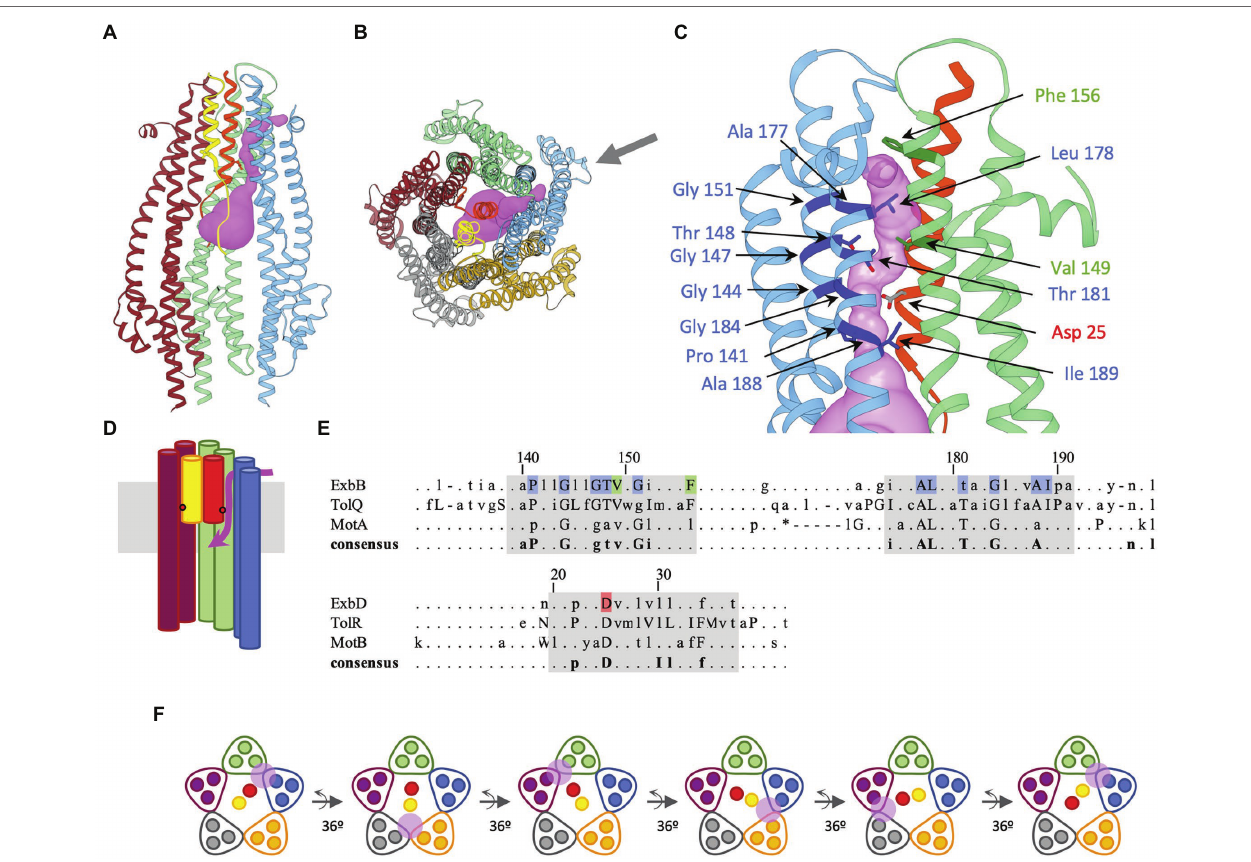
FIGURE 2 | Predicted proton channel in Ec ExbBD, sequence conservation of residues lining the channel, and rotary model of the ExbD TMs in the ExbB pentamer. The color coding of the different subunits is the same as in Figure 1 . (A) Ribbon representation of the Ec ExbBD complex (pdb 6TYI), with the predicted proton channel represented as pink isosurface. For clarity, two ExbB subunits (grey and orange) have been omitted to reveal the interior of the complex. The blue and green Ec ExbB subunits are involved in the channel formation. The TM helices of Ec ExbD are colored yellow and red, with the side chains of the essential Asp25 represented as ball and sticks. The red helix is involved in the formation of the channel. (B) Same ribbon representation as (A) , but viewed from the periplasm, all the Ec ExbBD subunits are shown. The online version of Mole 2.5 (https://mole.upol.cz/; Pravda et al., 2018) was used to probe for cavities and channels in the Ec ExbBD structure. The same parameters reported for the Cj MotAB channel (Santiveri et al., 2020) were used: 1 Å radius bottleneck, and omission of Leu178 side chain for the calculation. The black arrow shows the direction of viewing for (C) . (C) Enlarged view of the channel. Only the Ec ExbB and Ec ExbD subunits involved in the channel formation are shown (blue, green, and red). The most conserved residues in the consensus sequence shown in (E) are highlighted in darker colors and side chains are shown as ball and stick. (D) Schematic representation of (A) , showing the path of the channel. Only the TMs 2 and 3 of the blue, green, and purple Ec ExbB subunits are shown. The approximate location of the conserved Asp on Ec ExbD TM is shown with red dots. The membrane is shown in grey. The channel is symbolized in pink. It opens between the blue and green Ec ExbB subunits on the periplasmic side, connects to the Asp25 of the red Ec ExbD TM, and opens on the cytoplasmic cavity of the Ec ExbB pentamer. (E) Consensus from the multiple sequence alignment of ExbB/TolQ/MotA last two TM domains and ExbD/TolR/ MotB TM domain, adapted from Figure 4 from Cascales et al. (2001). Lowercase letters represent residues present in the 60% consensus and uppercase letters for residues in the 90% consensus. Gaps are marked “–” and “*” when present in the 90 and 60% consensus, respectively (Cascales et al., 2001). The numbering corresponds to the E. coli sequences of ExbB and ExbD. The highlighted residues in blue, green, and red are the ones shown with arrows on (C) . They all are in the 90% consensus range, except for Thr181. The regions highlighted in grey correspond to the last two TMs of ExbB, TolQ, and MotA, and the single TM of ExbD, TolR, and MotB. (F) Rotary model of ExbBD. The view is the same as in (B) and shows a schematic slice of the TM domains of ExbB and ExbD. The positions of the proton channel are shown with the pink circle. The cycle starts with the channel opening between the green and blue ExbB subunits. The proton travels to the conserved Asp on the red ExbD TM, inducing a conformational change resulting in the rotation of the two ExbD TMs by 36 ° . The conformational changes lead to the closure of the channel between the green and blue ExbB subunits, while a new channel opens between the grey and orange ExbB subunits. A second proton now travels to the Asp on the yellow ExbD TM, resulting in a new rotation of 36 ° . The channel between the grey and orange ExbB subunits closes, while a new channel opens between the purple and green subunits, allowing a third proton to travel to the Asp on the red ExbD TM. The rotation can proceed as long as the channels are in the open state. Molecular graphics have been performed with UCSF Chimera (Pettersen et al.,